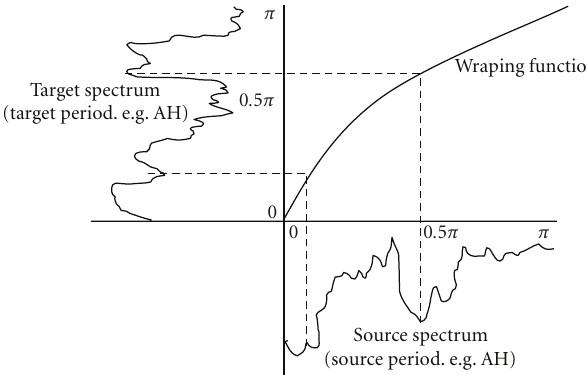
Figure 3: The warping function used in the frequency domain.